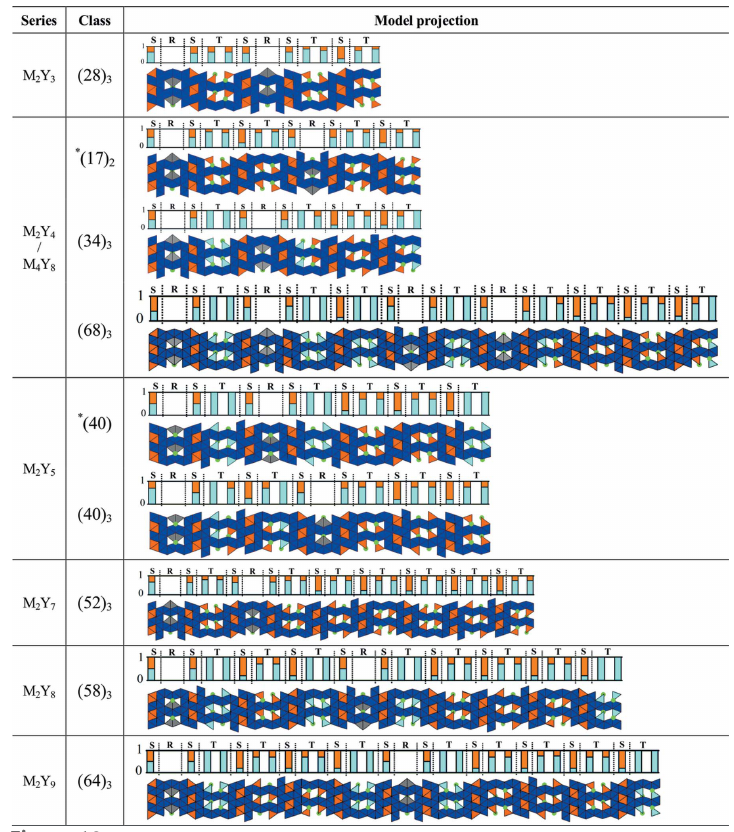
Figure 10 Projections of the mixed-layer hexaferrites along the [100] direction, the location of zinc is highlighted in orange. The asterisk indicates a class with a hexagonal or trigonal symmetry, all others are rhombohedral. For the latter, unit cells contain a threefold repeat of the represented sequences, with subsequent repeats translated in-plane by (2/3, 1/3). The histograms show iron (light blue) and zinc (orange) occupancies in tetrahedral